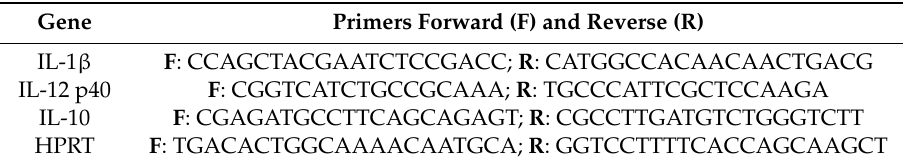
Table 1. List of